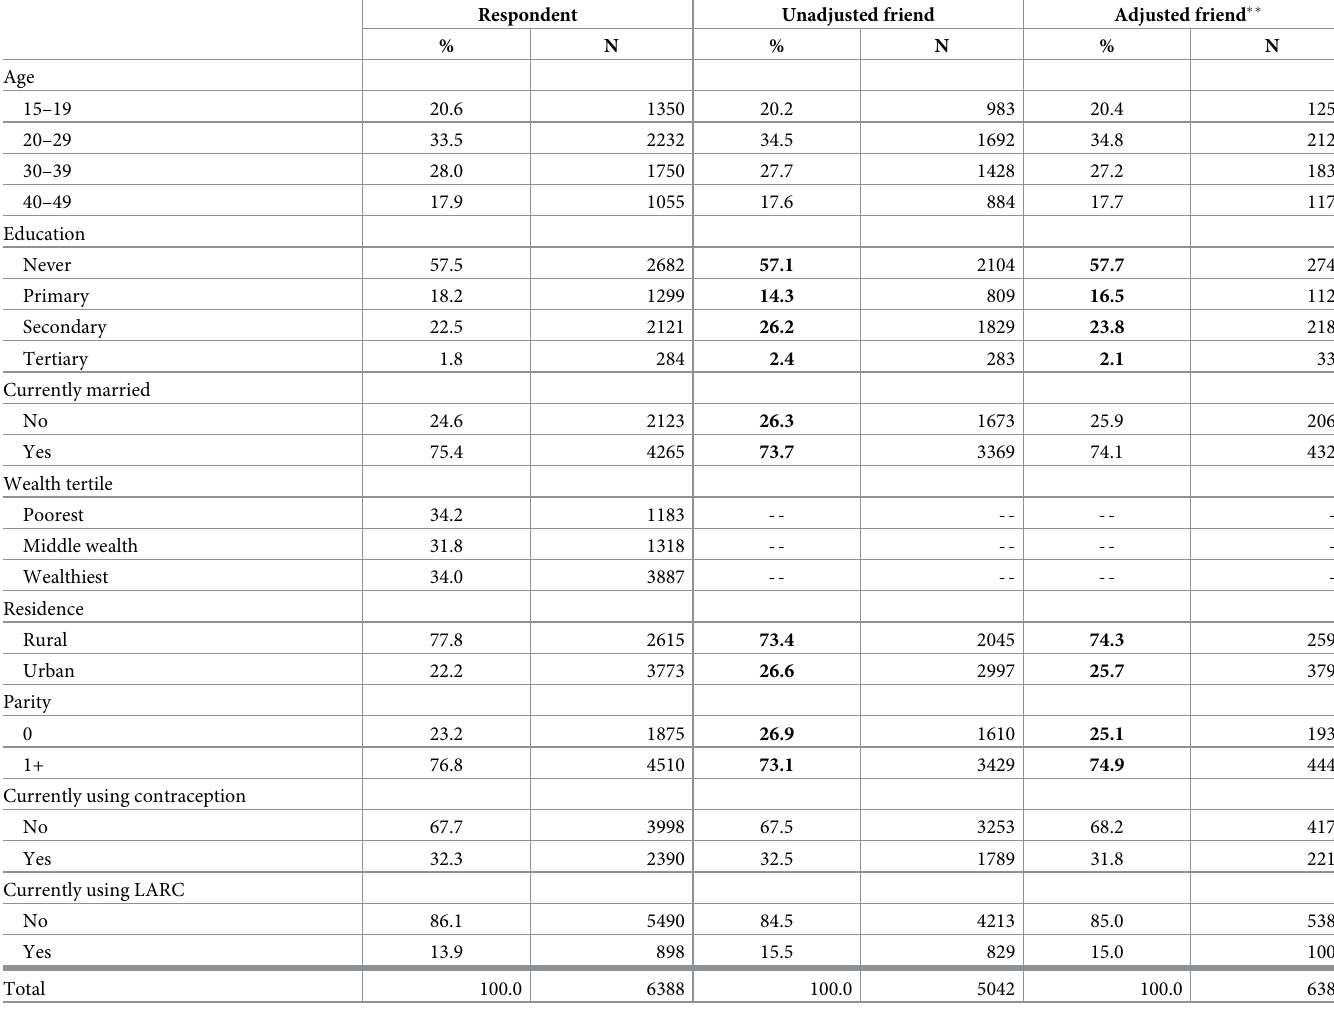
Table 1. Characteristics of female respondents aged 15 to 49 and their closest female friends age 15 to 49 in Burkina Faso �